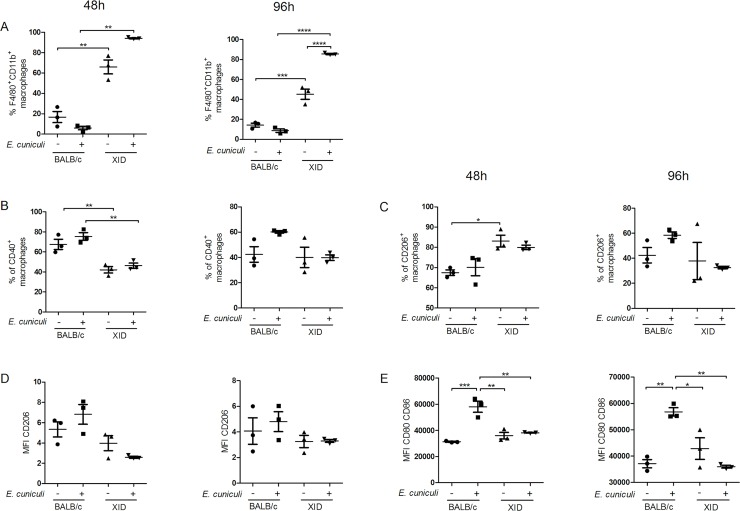
Activation phenotype of macrophages from BALB/c or XID APerC infected with E. cuniculi spores.(A) Total percentage of F4/80+CD11b+ macrophages. (B) Proportion of F4/80+CD11b+ macrophages expressing CD40+. (C) Proportion of F4/80+CD11b+ macrophages expressing CD206. (D) Mean fluorescence intensity (MFI) ratio of CD40/CD206 molecules expression on F4/80+CD11b+ macrophages. (E) Mean fluorescence intensity of CD80+ and CD86+ coestimulatory molecules on macrophages. The data are represented as mean ±SEM (* P <0.05, ** P <0.01, *** P <0.001, **** P <0.0001, One way ANOVA with multiple comparisons and Bonferroni post-test).